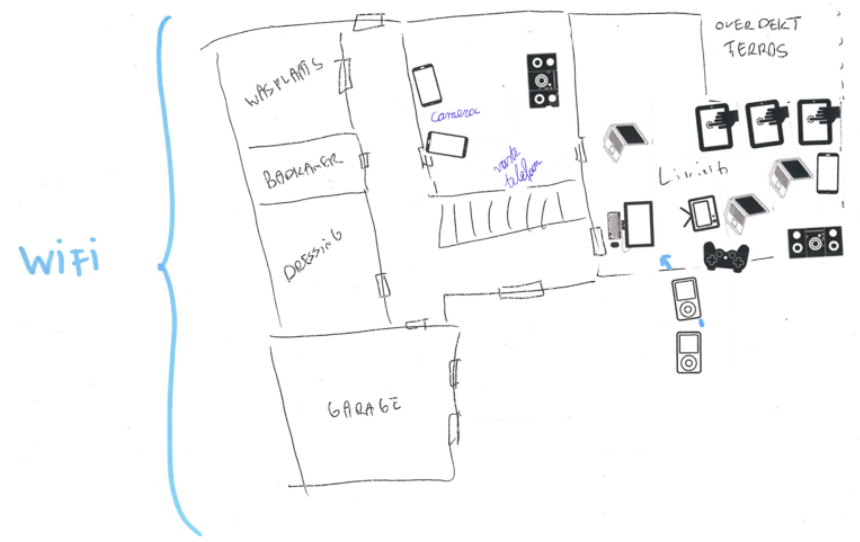
Figure 1. Example of a child’s media use map. and decision-making. The other axis used the quadru- ple R principles, as explained above, to analyse how and when parents and children invoked them. For